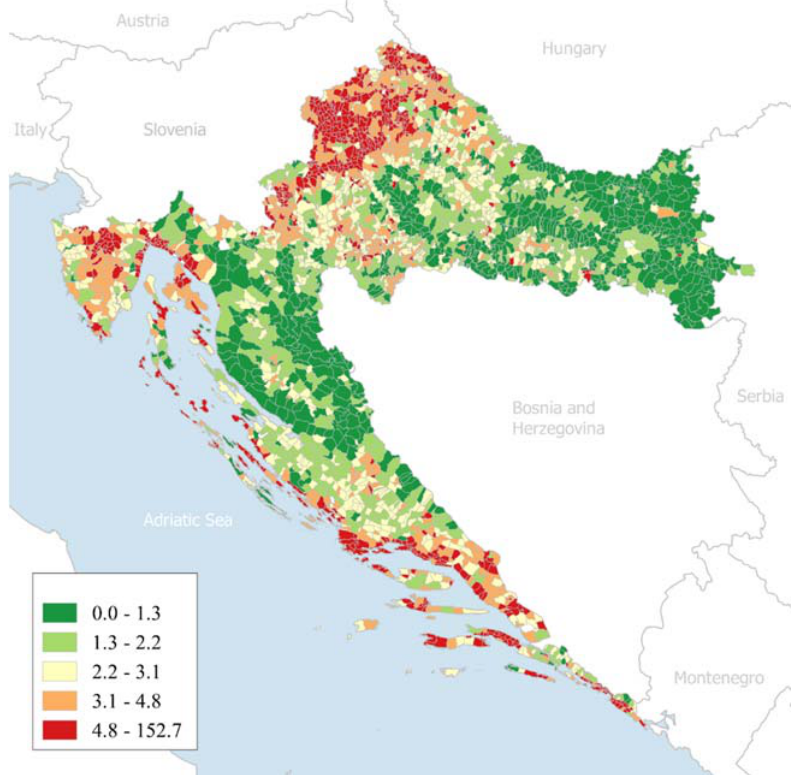
Figure 2. Average number of land parcels per hectare.